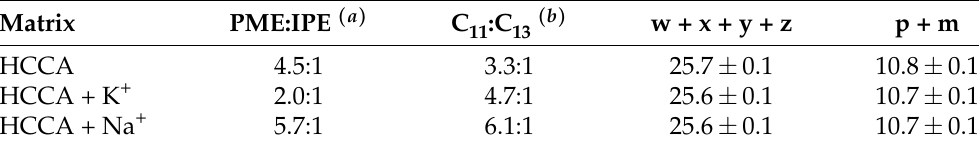
Table A1. Key findings from mass spectrometry measurements of Tween20: the ratio between PME and IPE species, the ratio between C 11 and C 13 alkyl chains of the hydrophobic tail and the total number of EO groups per molecule: w + x + y + z of PME, p + m of IPE; ( a ) determined as the ratio of the peak areas from molecules with a C 11 alkyl chain; ( b ) determined as the ratio of the peak areas of